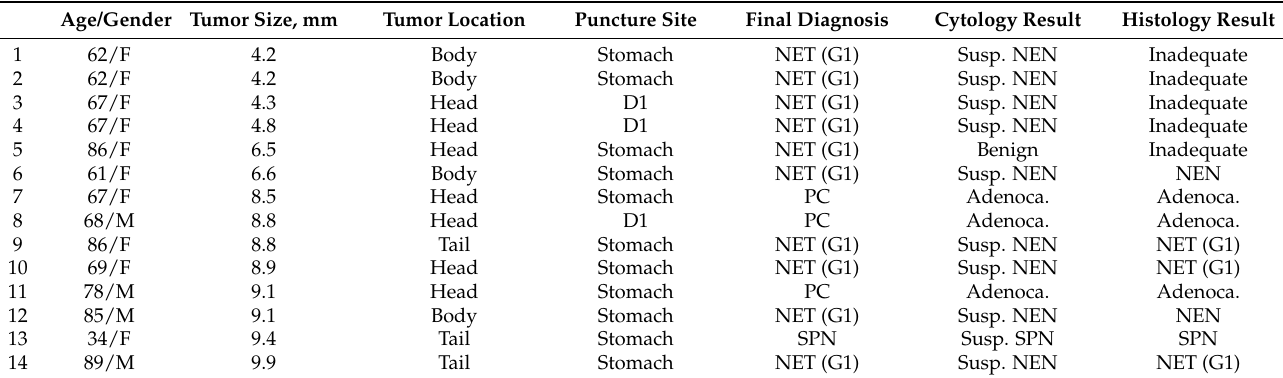
Table 7. Detailed results of EUS-FNB for lesions smaller than 10